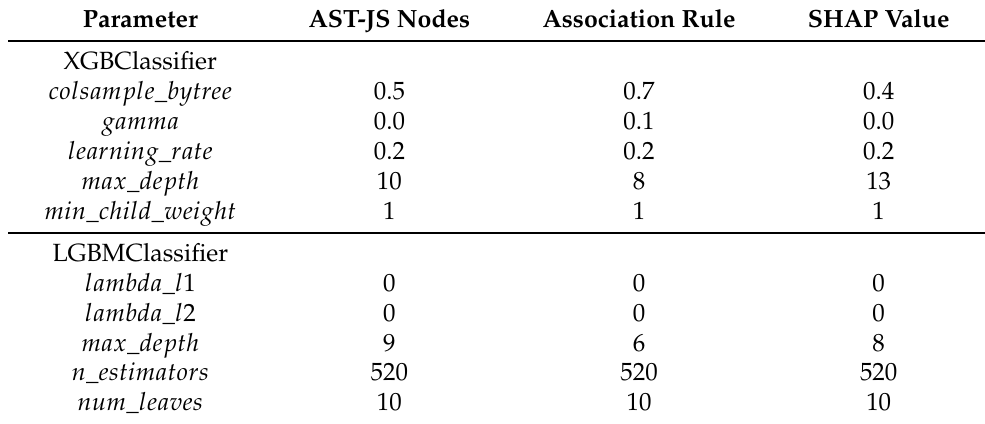
Table 1. XGBClassifier and LGBMClassifier